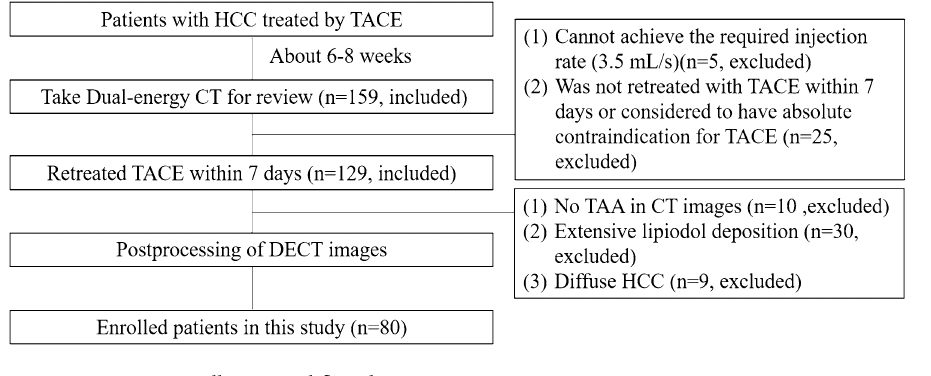
Figure 1. Patient enrollment workflow